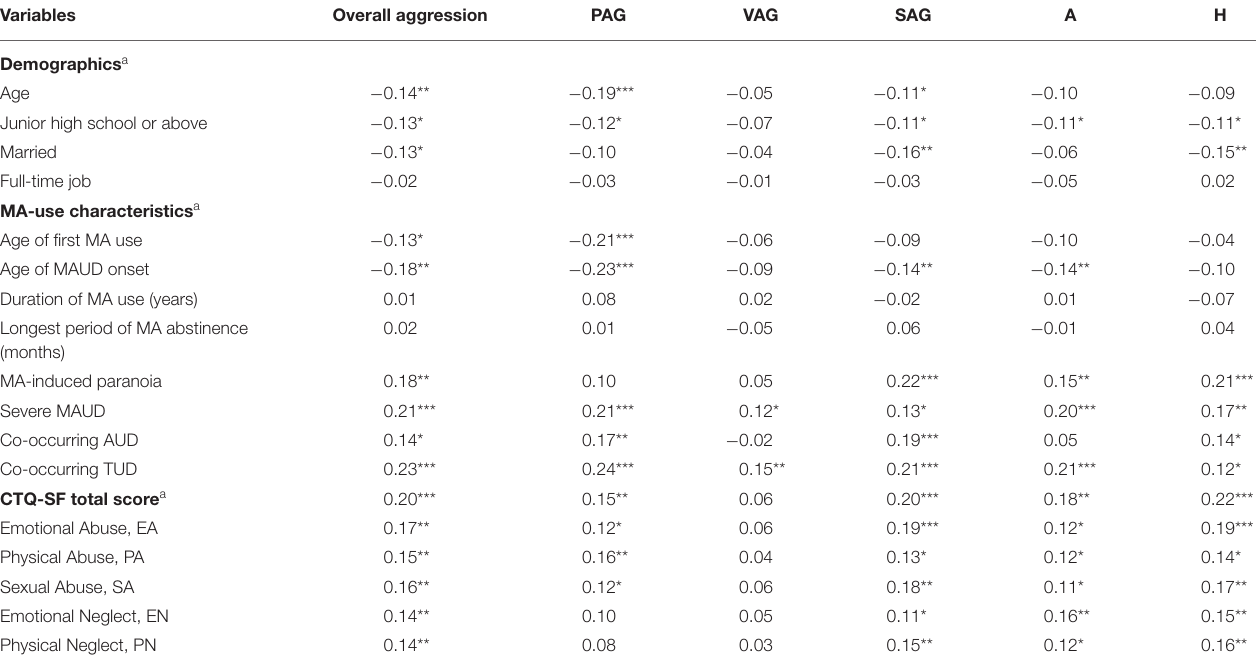
TABLE 2 | Univariate analyses of